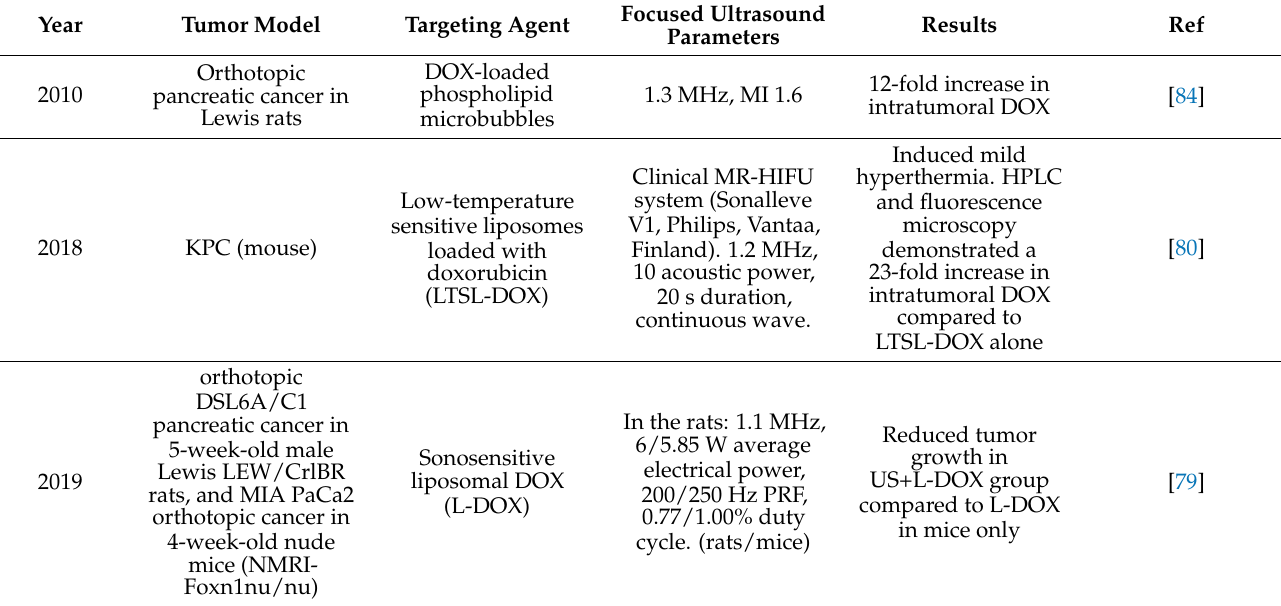
Table 1. Studies on FUS-mediated targeted drug delivery in pancreatic tumor